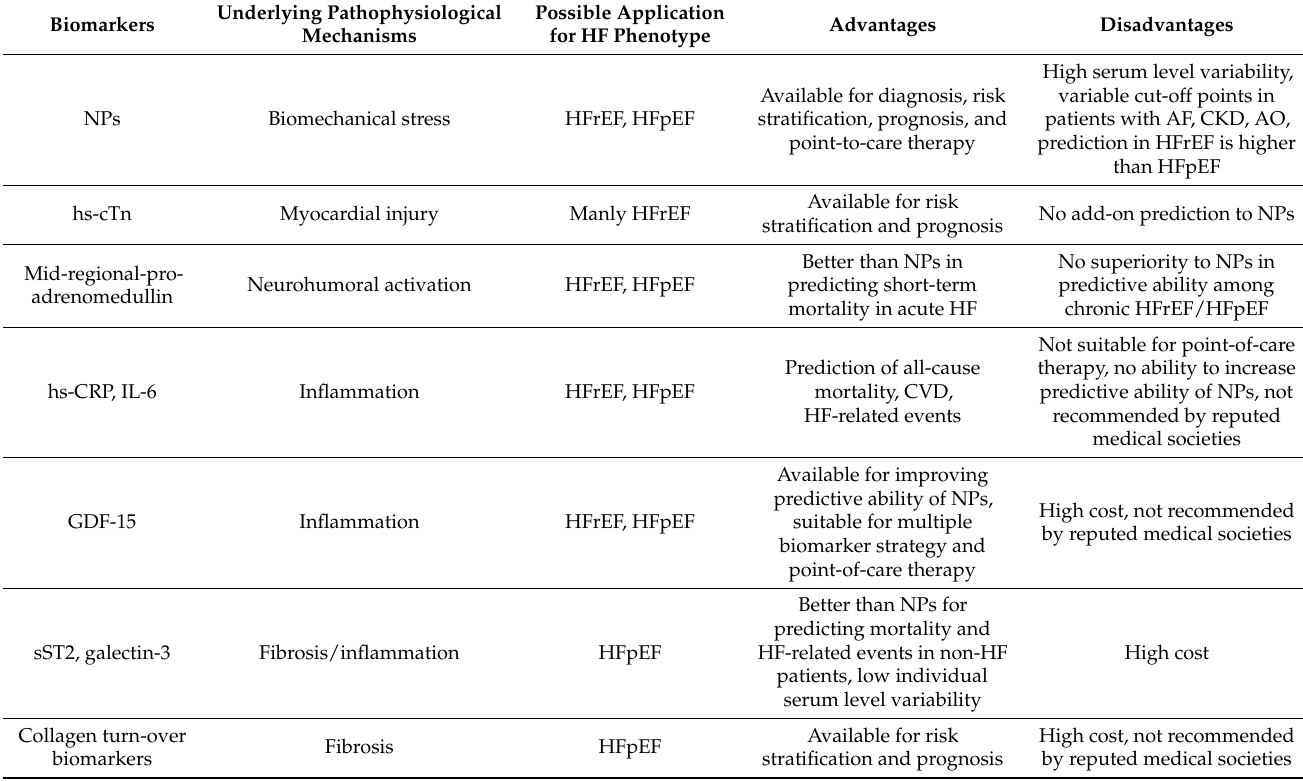
Table 2. Advantages and disadvantages of HF biomarkers in T2DM